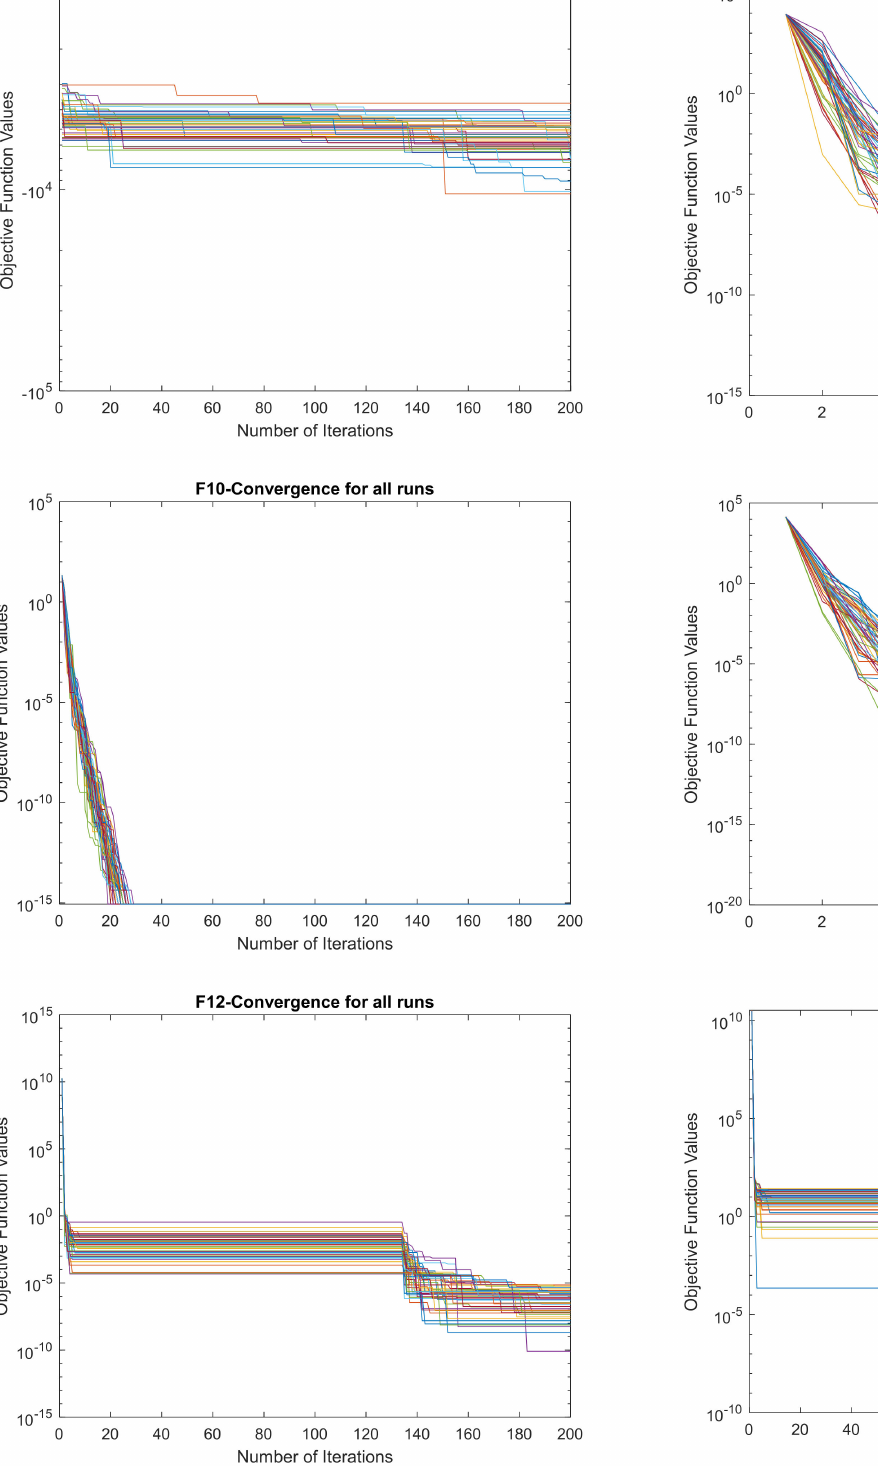
Figure 12. Convergence of MAO over 50 trials for multimodal functions of 50-dimensional